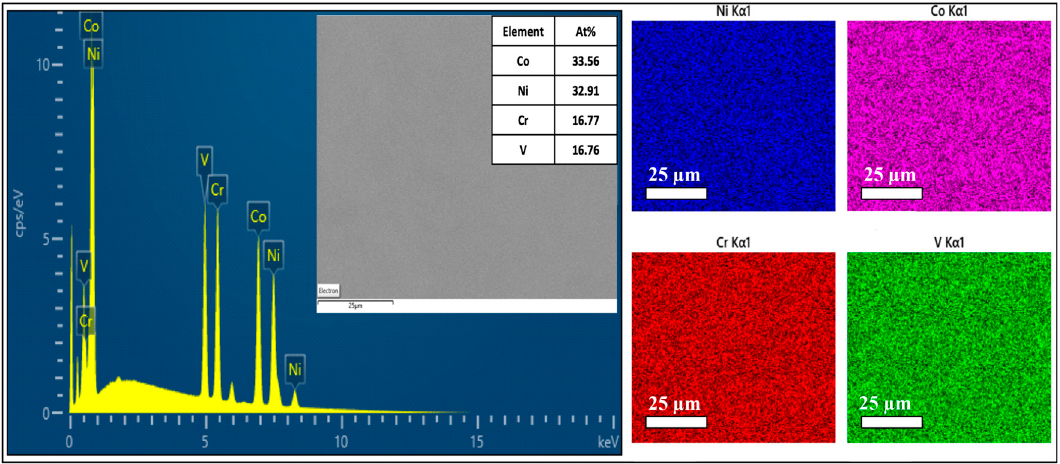
Figure 2. The EDS area mapping of the CoNi(Cr 0 . 5 V 0 . 5 ) (CNCV) sample.